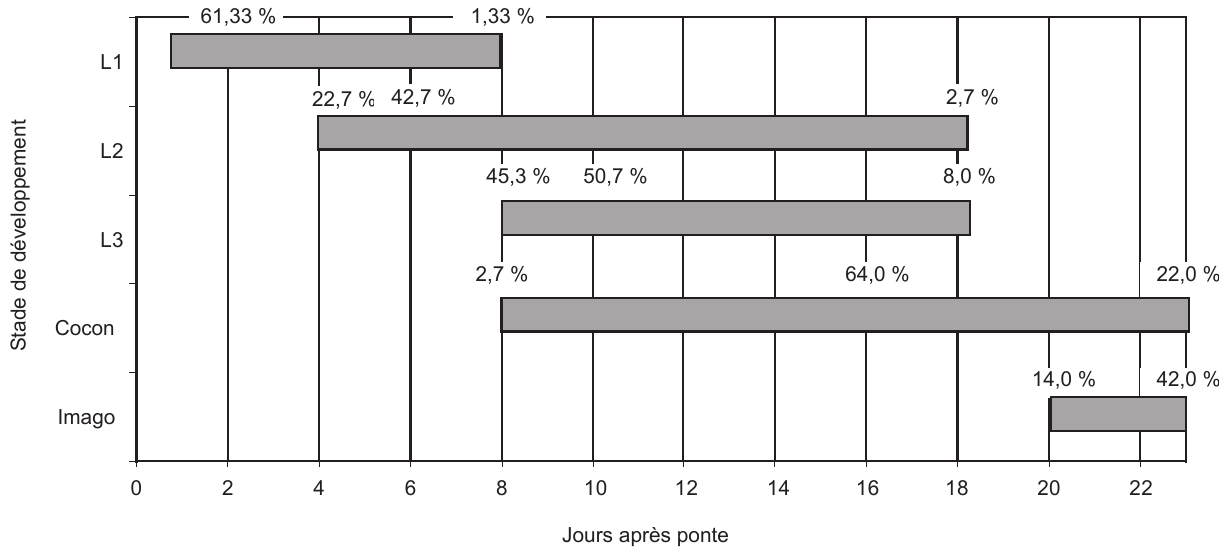
Fig. 4. – Chronologie d’apparition des différents stades de développement de C. f. strongylus à 27°